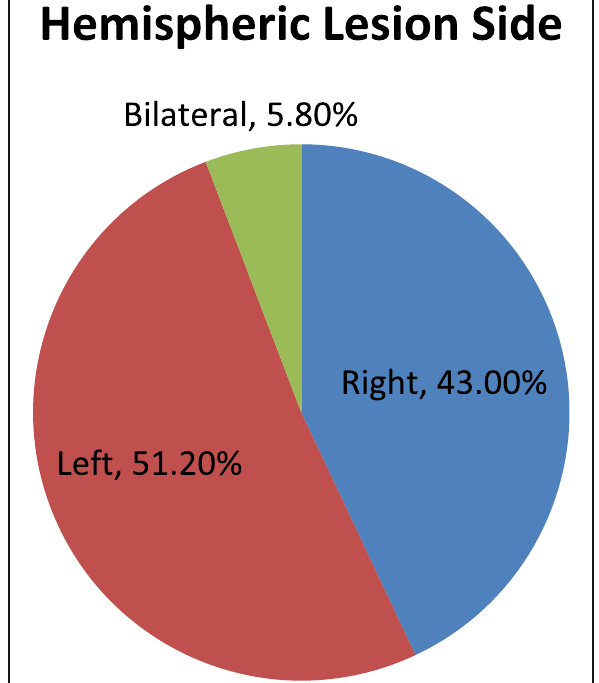
Fig. 2 Hemispheric side distribution of ischemic lesion among study